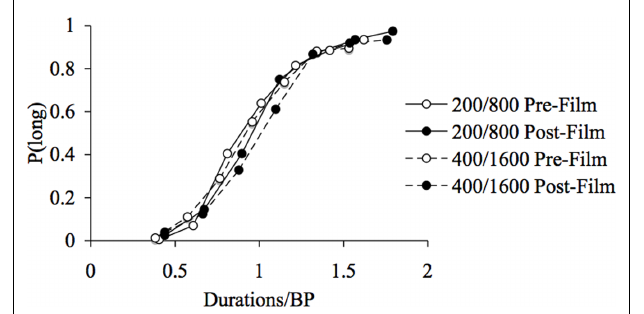
FIGURE 4 | Superimposition of psychometric functions for fear. Proportion of long responses plotted against probe durations divided by the bisection point (BP) for the pre- and post-film bisection task in the 200/400 and the 800/1600-ms duration